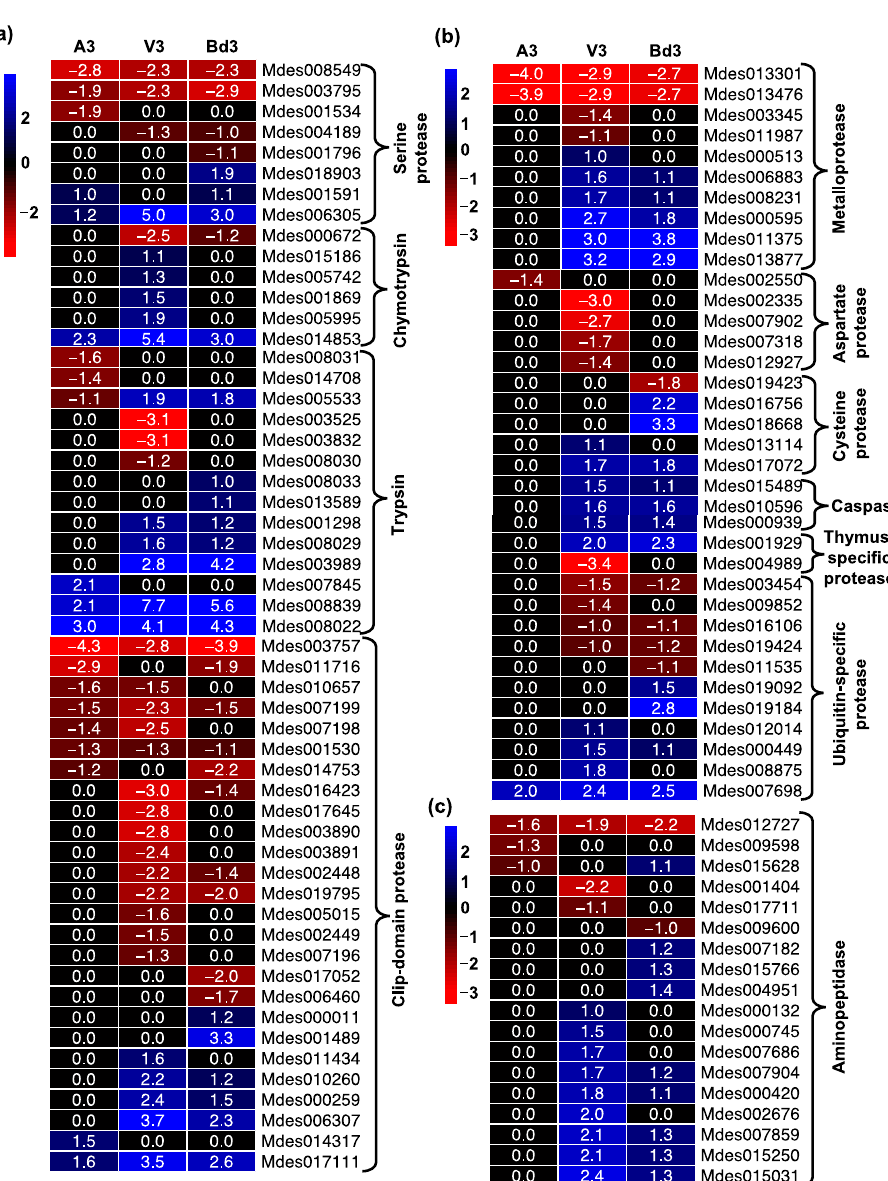
Figure 7. Differential expression of proteases in Hessian fly larvae 3 days after hatch (DAH). Heatmaps depict expression profiles of genes encoding several families of proteolytic enzymes in avirulent (A3), virulent (V3), and Bd3 larval transcriptomes. ( a ) Differential expression of genes en- coding serine proteases including chymotrypsins, trypsins, and clip-domain proteases. ( b ) Expression of genes encoding metalloproteases, aspartate protease, cysteine protease, caspase, thymus-specific proteases, and ubiquitin-specific proteases. ( c ) Differential expression of genes encoding aminopeptidases. Log2 fold-change RNA-Seq values are shown within each cell of the heatmap. Blue represents up-regulated genes, and red represents the down-regulated genes, while genes not differentially expressed at a particular time-point are indicated in black.